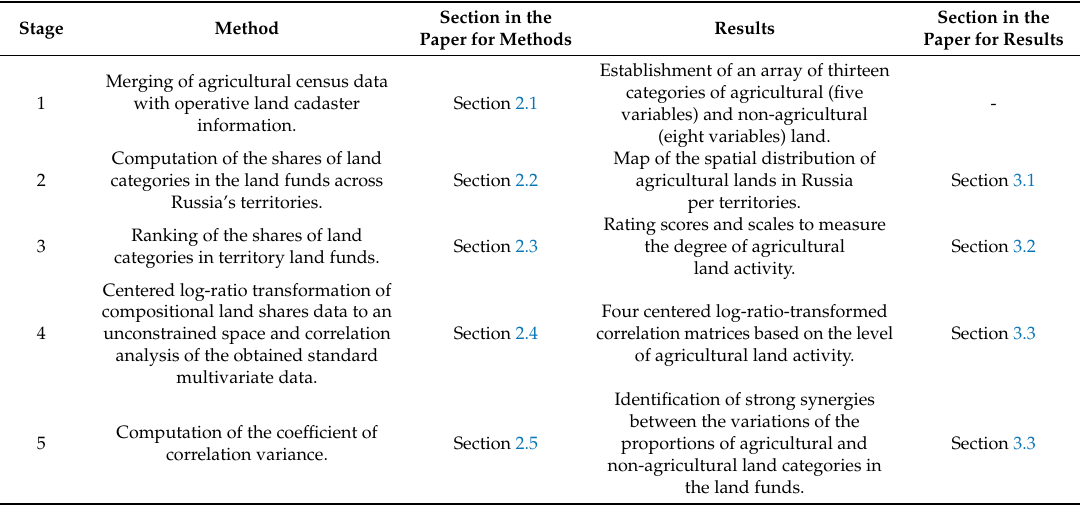
Table 1. Study flow